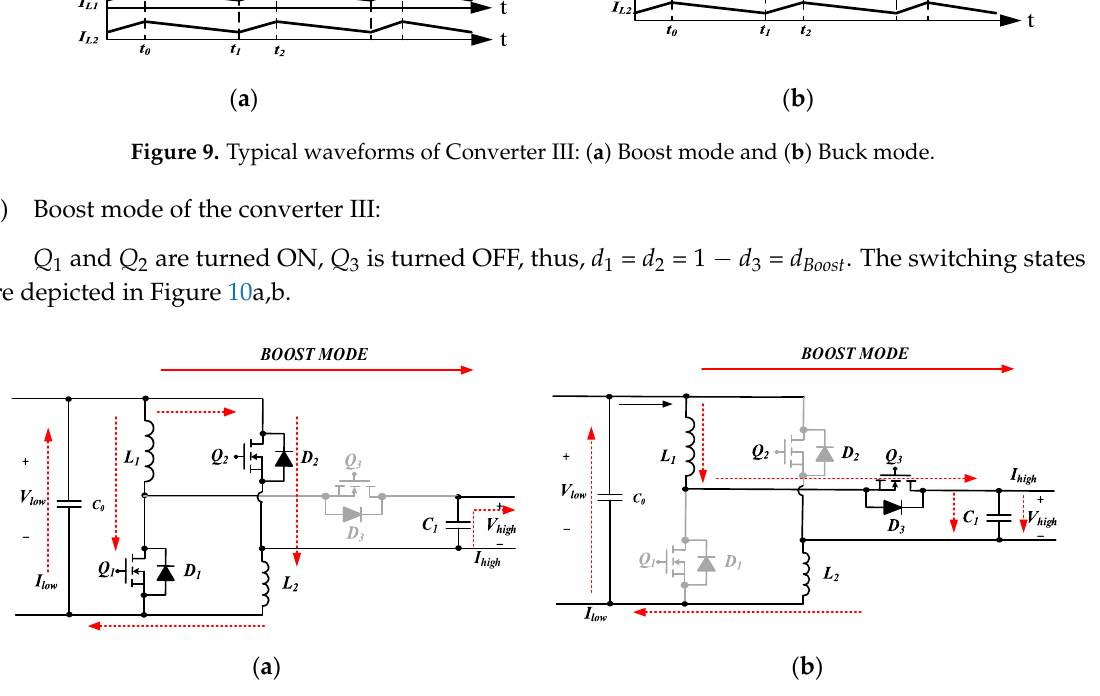
0 – t 1 ]. ( b ) [ t 1 – t 2